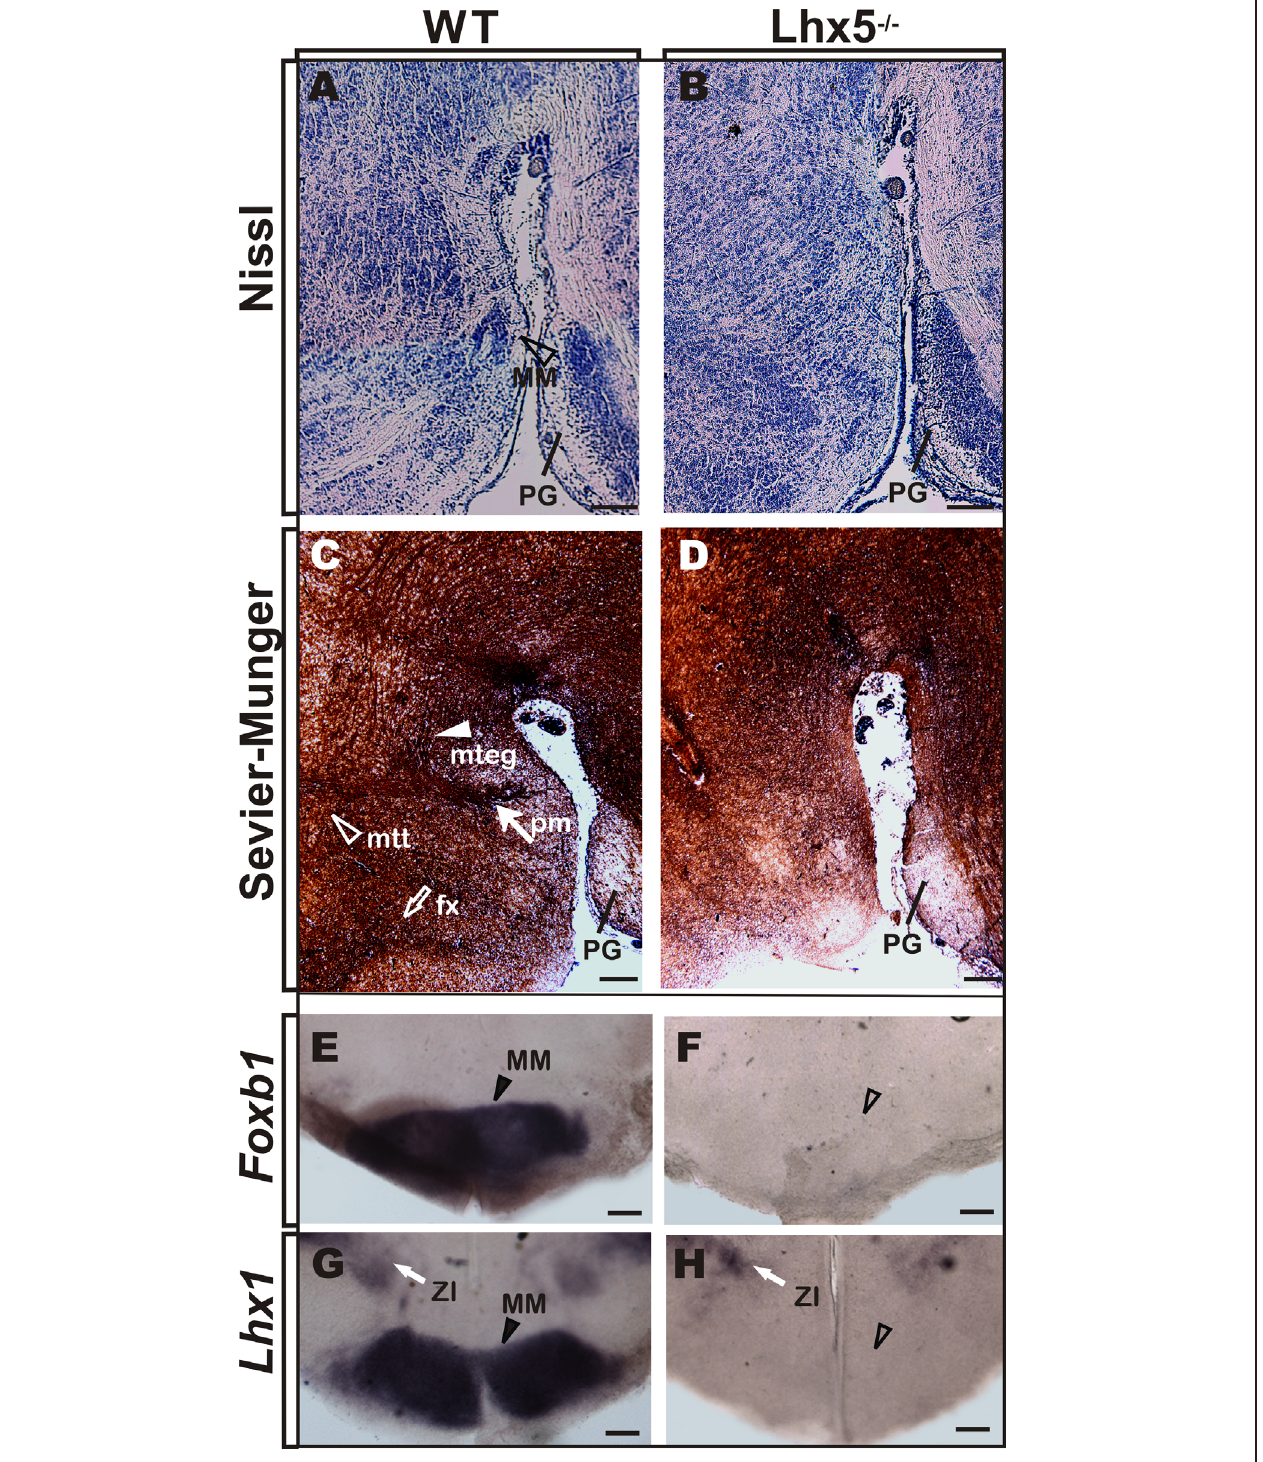
FIGURE 2 | MM is absent in Lhx5 mutants. (A,B) Nissl staining in sagittal sections of control mice at E18.5 reveals the MM (arrowhead) that appears absent in Lhx5 mutants. (C,D) Comparable sections processed for Sevier–Munger silver staining reveal the fx (empty arrow), pm (filled arrow), mtt, (empty arrowhead), and mteg (filled arrowhead) tracts, in control but not in mutant littermates (anterior is to the left). (E–H) In situ hybridization for Foxb1 and Lhx1 in E18.5 coronal sections stained the MM in controls (arrowhead) and showed no expression in Lhx5 mutants. Note the presence of Lhx1 expression in the ZI (white arrow). Abbreviations: fx, fornix; MM, mamillary; mteg, mammillotegmental; mtt, mammillothalamic; PG, pontine gray; pm, principal mamillary; ZI, zona incerta. Scale bar: 400 µ m.